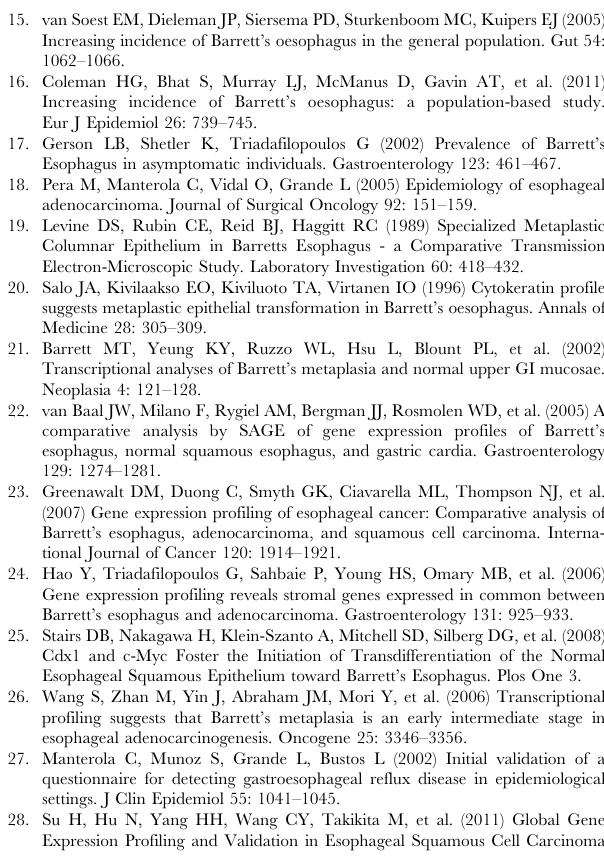
Table S1 Demographic and risk factor information for BE cases. Table S2 Endoscopy findings for BE cases. Table S3 Pathology findings for cardia, BE, and squa- mous esophagus biopsies from BE cases.